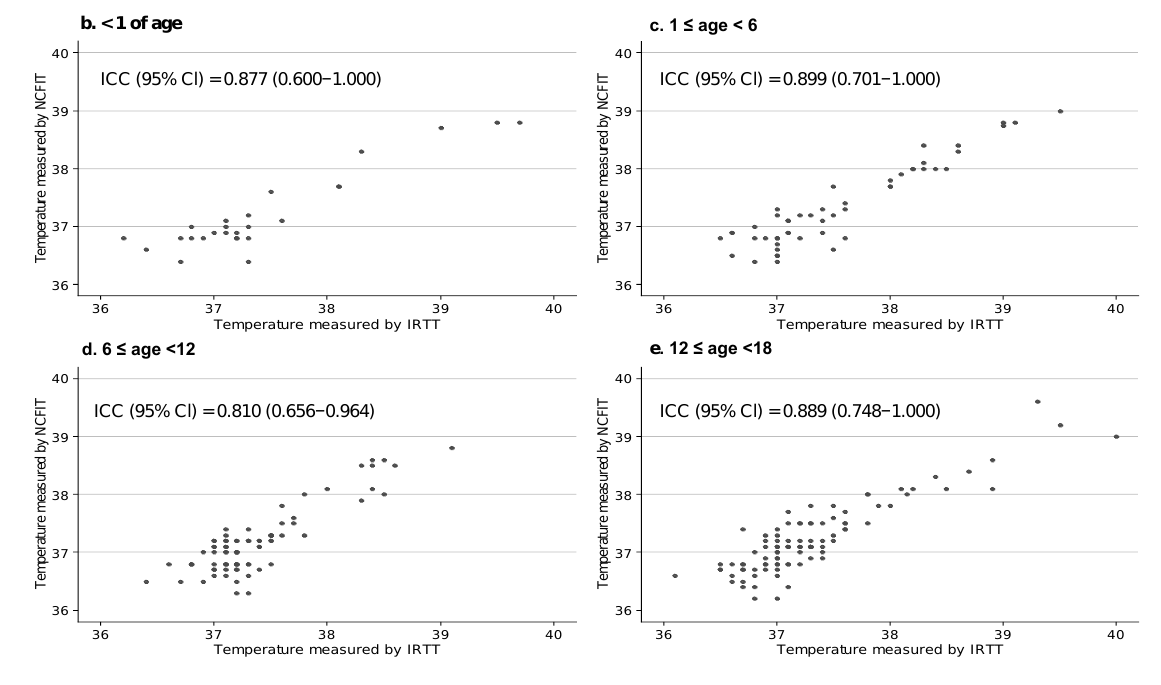
Figure 2. Agreement between NCFIT and IRTT by intra-class correlation coefficient. ( a ) Overall, ( b ) <1 year of age, ( c ) 1–5 years of age, ( d ) 6–11 years of age, and ( e ) 12–18 years of age. 3.3. Validity of Fever Detection Based on 38.0 ◦ C of IRTT The sensitivity, specificity, PPV, and NPV of the NCFIT measurement were 0.81 (95% CI: 0.70–0.93), 0.98 (95% CI: 0.96–0.99), 0.90 (95% CI: 0.80–0.99), and 0.96 (95% CI: 0.93–0.98), respectively, in the overall age group (Table 3). The sensitivity was 0.66 (95% CI: 0.28–1.00) and 0.76 (95% CI: 0.56–0.96) for children aged <6 years, i.e., the <1-year and 1–6 years age groups, respectively, showing a rather low sensitivity. In contrast, for children aged >6 years, the sensitivity was >0.90. The specificity was 0.98 (95% CI: 0.96–0.99) in the overall age group, and the lowest specificity was observed for the 6–11 years age group (0.94 [95% CI: 0.93–1.00]). The PPV (0.90 [95% CI: 0.80–0.99]) and NPV (0.96 [95% CI: 0.93–0.98]) were also high in the overall age group. The PPV was the lowest in the 6–11 years age group, being 0.81 (95% CI: 0.59–1.00). The NPV was the lowest in the 1–5 years age group, being 0.89 (95% CI: 0.19–0.99) (Table 3).